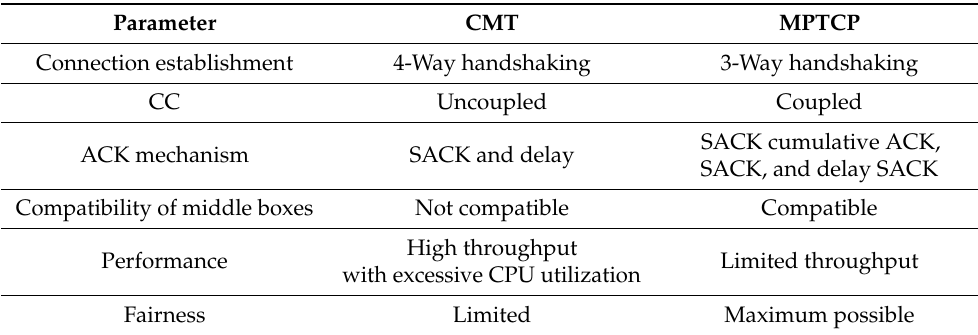
Table 6. Comparison of CMT-SCTP and MPTCP